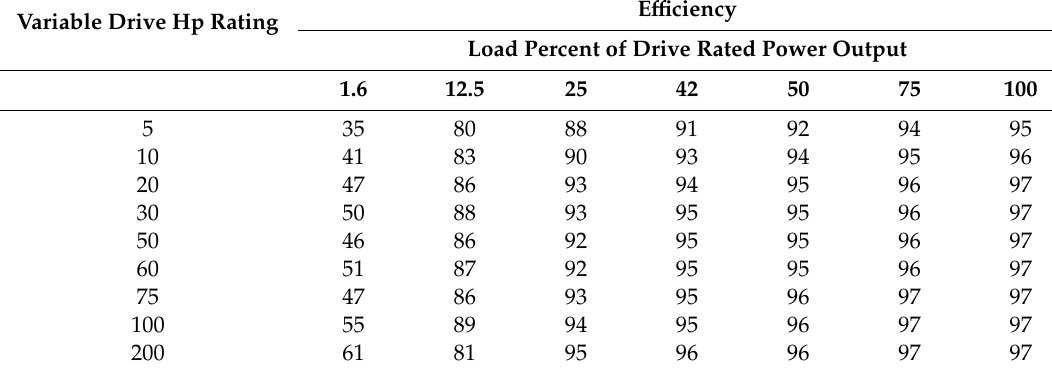
Table 7. Adjustable Speed Drive Part-Load E ffi ciency (n VSD ), typical for Pulse-Width-Modulated (PWM) type Variable Frequency Drive (VFD)